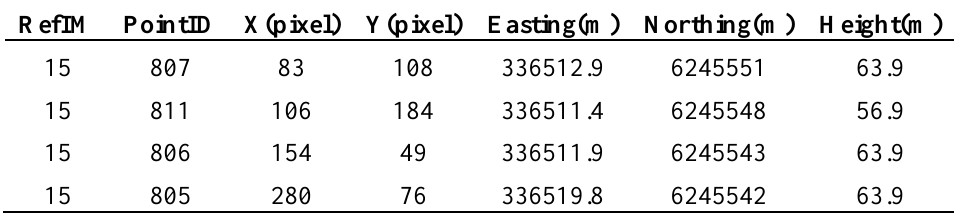
Table 1. Geo-located corner points for reference image No. 15, X, Y in pixel and Easting, Northing and Height in meters.